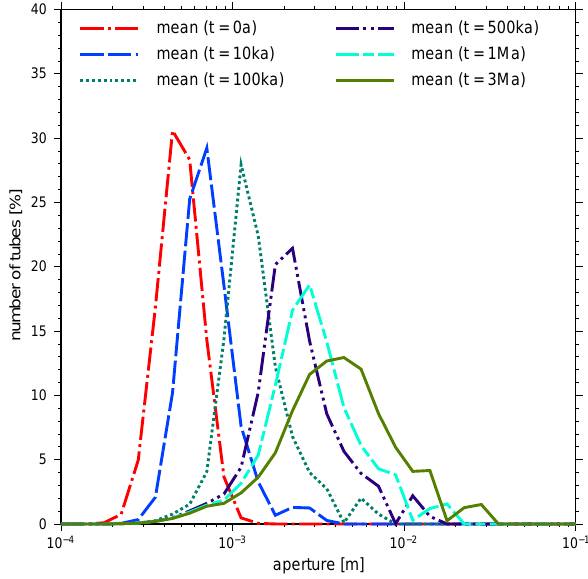
Fig. 8. Long-term evolution of the mean aperture distribution in the low-heterogeneity settings with strongly limited maximum recharge rates of Q max = 10 − 8 m 3 s − 1